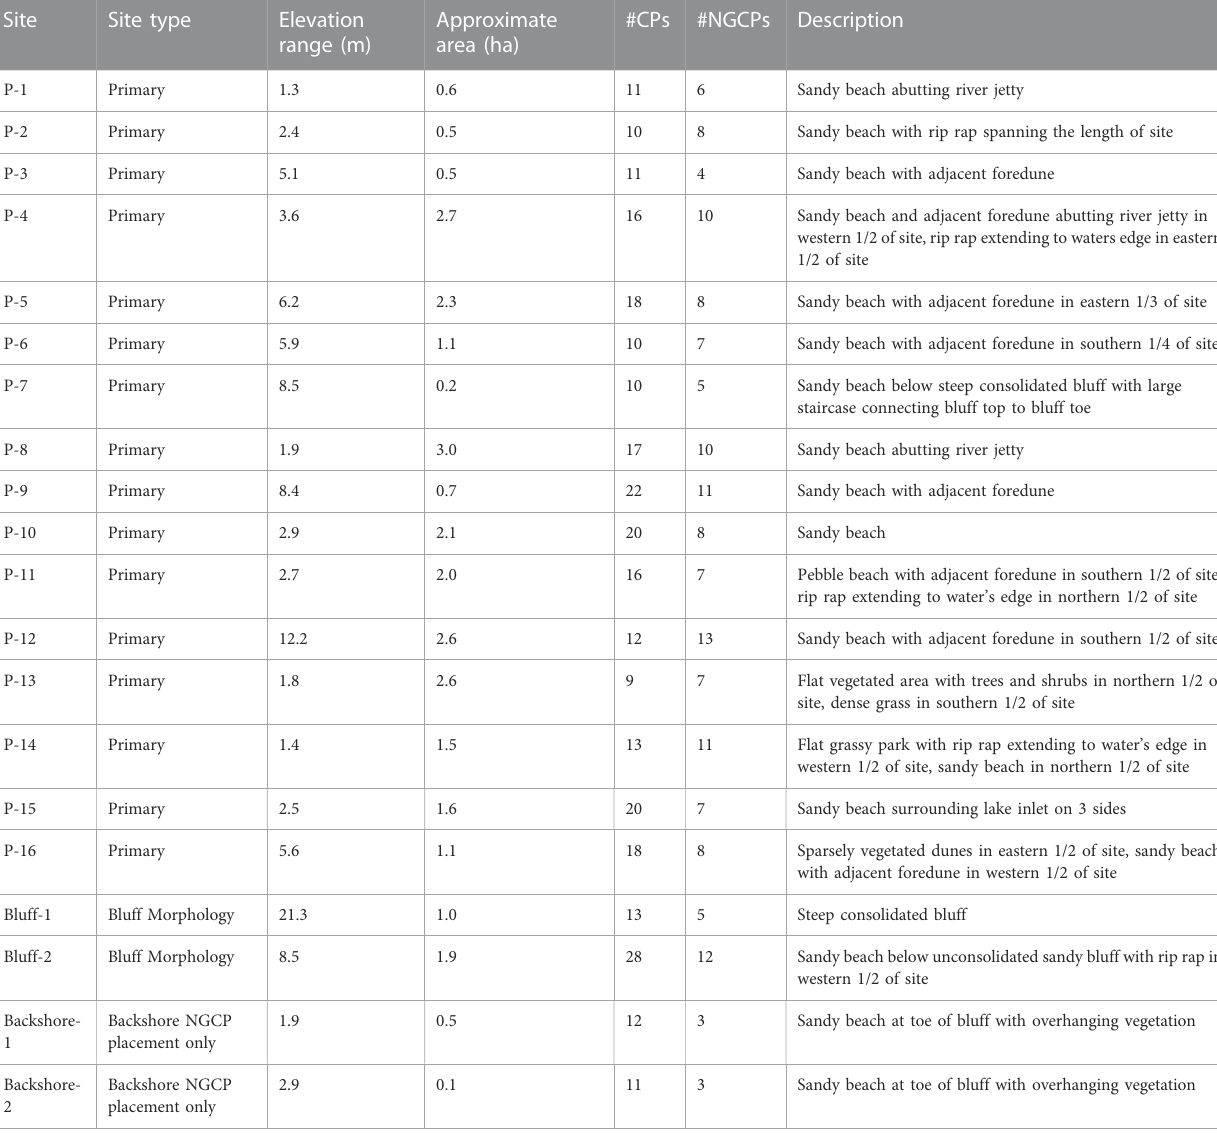
TABLE1Sitetype,elevationrange,approximatearea,quantityofNGCPsandCPs,anddescriptionofall20sitesincludedinthisstudy.Elevationrangeiscalculated from the difference between the highest and lowest NGCP/CP within the site. Approximate area excludes excess area outside the boundaries of the site captured by NGCPs/CPs. #CP and # NGCP refer to the quantity of check points and natural ground control points surveyed at the site. Starred sites indicate those used for the analysis of NGCP quantity and